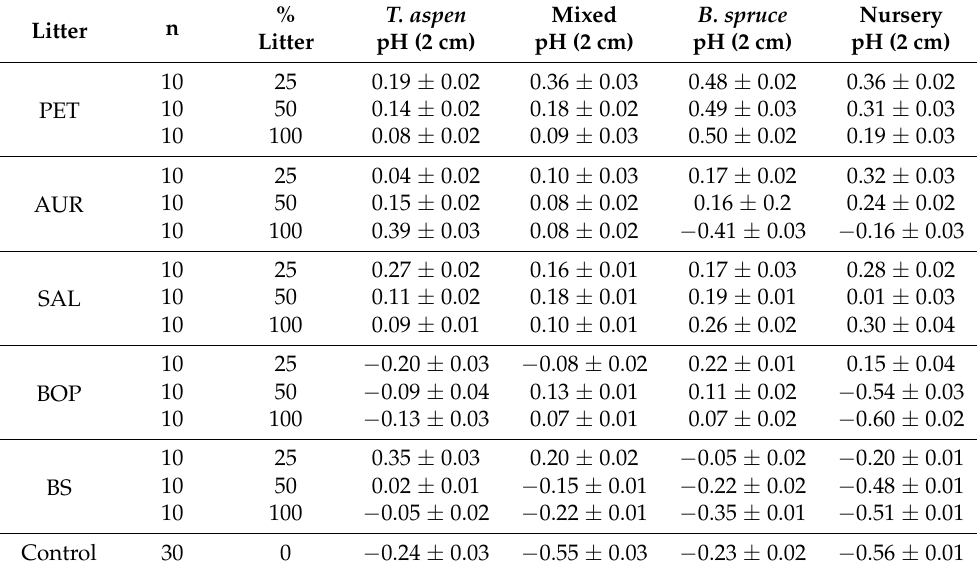
Table 3. Final pH changes over 150 days (measured at 2 cm depth from the surface) ± SD according to humus category and rate of litter addition. PET: T. aspen ; AUR: Alder sp.; SAL: Willow sp; BOP: White birch ; BS: B. spruce ; Control: no addition. % T. aspen Mixed B. spruce Nursery Litter n